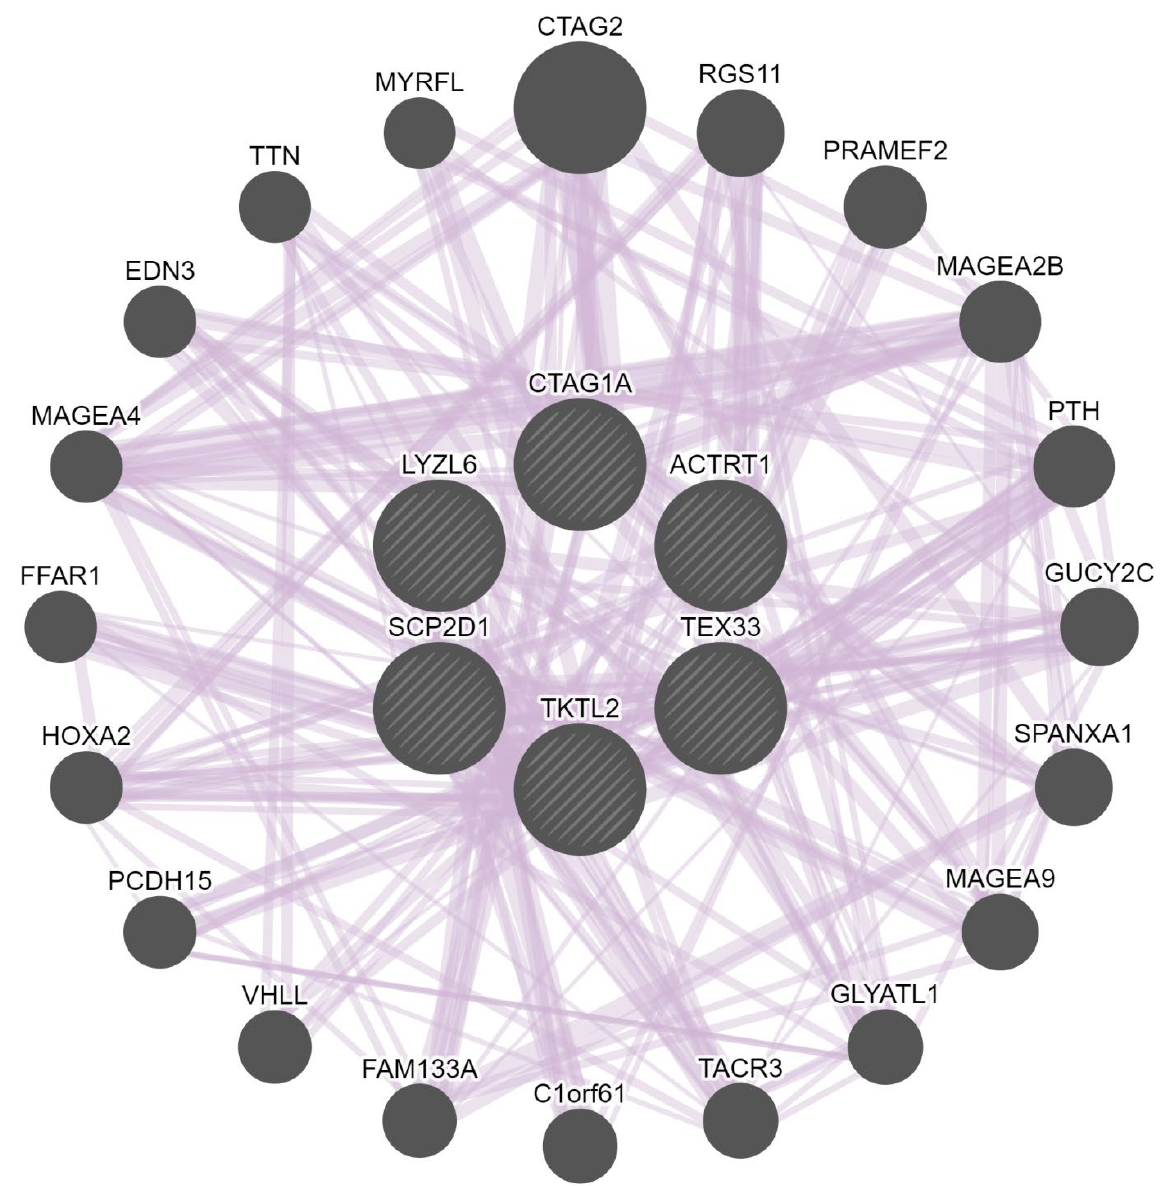
Figure 8. The gene–gene interaction network for the CT genes (SCP2D1, CTAG1A, LYZL6, TKTL2, ACTRT1, and TEX33) generated using the GeneMANIA database. Each central node represents a CT gene (shown as circles). The 20 most frequently neighboring genes found to be strongly linked to the CT genes are shown. The interactions between the CT genes and the other genes are shown as edges (shown as lines).